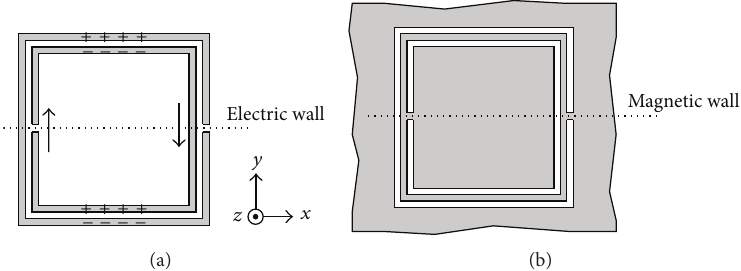
Figure1:TypicaltopologyofanSRR(a)andaCSRR(b).AsketchofthecurrentsandthedistributionofchargesfortheSRRatthefundamental resonance is also indicated (notice that the symmetry plane is an electric wall). From Babinet’s principle, it follows that the CSRR exhibits a magnetic wall at the symmetry plane.